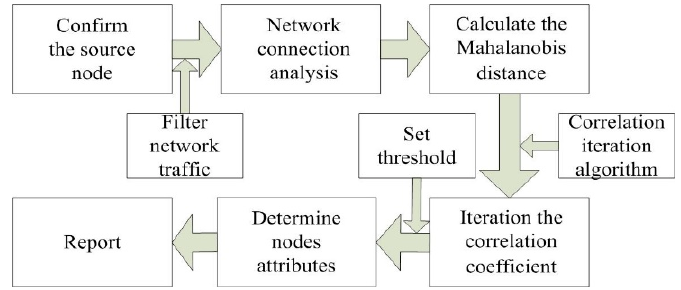
Figure 2. P2P botnet detection architecture.